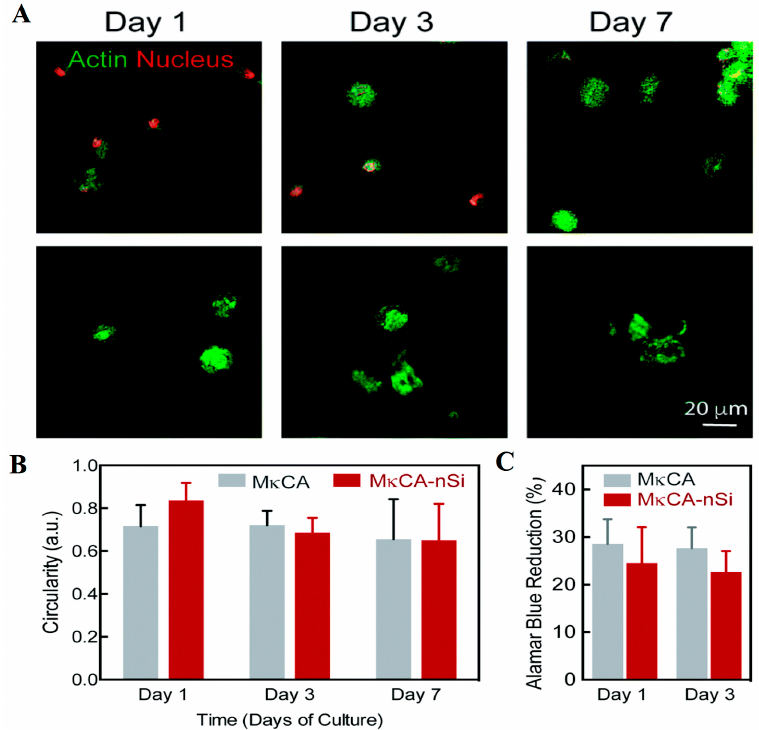
Figure 3. ( A , B ) Effect of nano silicate on spread ability of hMSCs over a period of 7 days. It can be seen from the confocal images that hMSC-treated cells were able to show circular morphology, indicating that hMSC can be delivered for cartilage regeneration. ( C ) Shows that there is no change in the metabolic activity of seeded cells. Reproduced with permission from [63]. Furthermore, an antimicrobial-based approach for wound healing and tissue generation was also adopted for CG based formulations. Polyox-CG composite based solvent cast film consisting of streptomycin (30% w / w ) and diclofenac (10% w / w ) was developed for wound healing purposes. The films showed antimicrobial activity against Staphylococcus aureus , Pseudomonas aeruginosa and E. coli [65] . As discussed in the previous sections, being sulfated polysaccharides; CGs themselves possess protective mechanisms against infectious agents, which may aid in providing improved wound regeneration and healing. Table 4. Scaffolds of some of the natural biomaterials and their probable mode of corneal repair in ocular therapy.